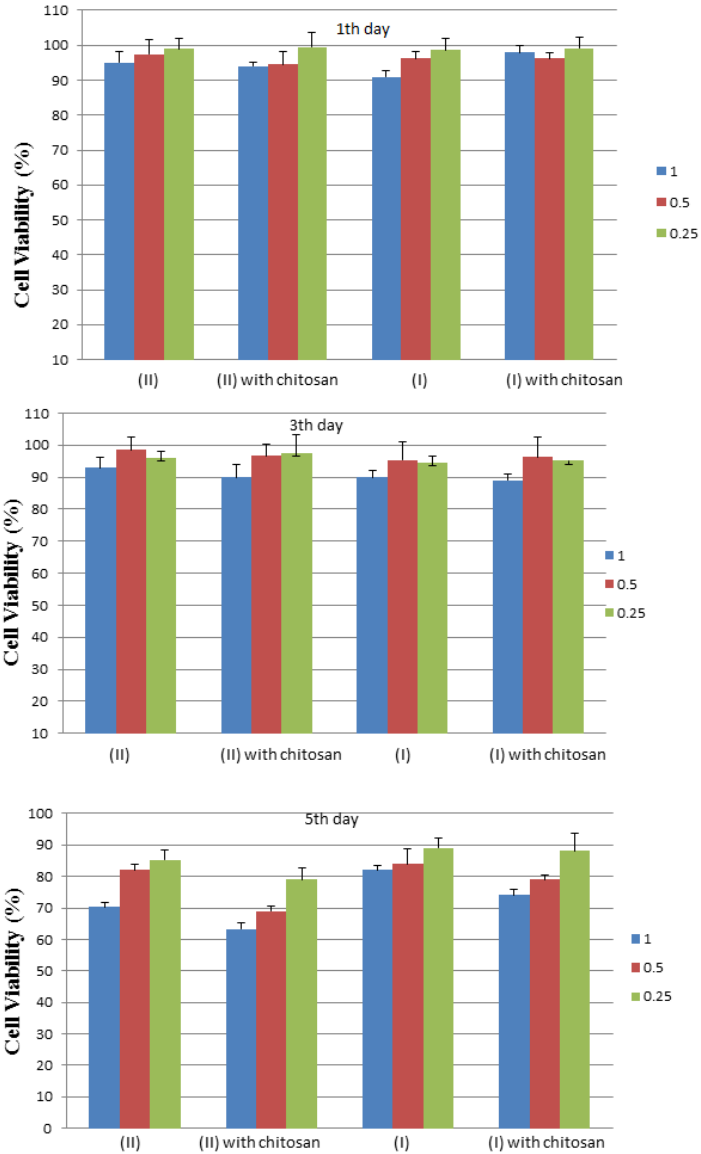
Fig. 3. The curves of nanoemulsion cytotoxicity in different times and